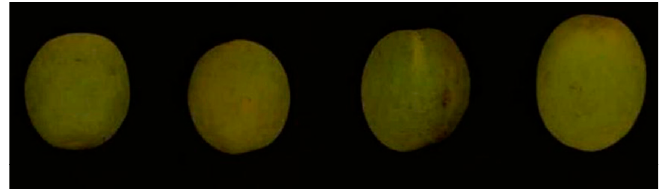
Figure 2. Pseudocolor images of some samples.